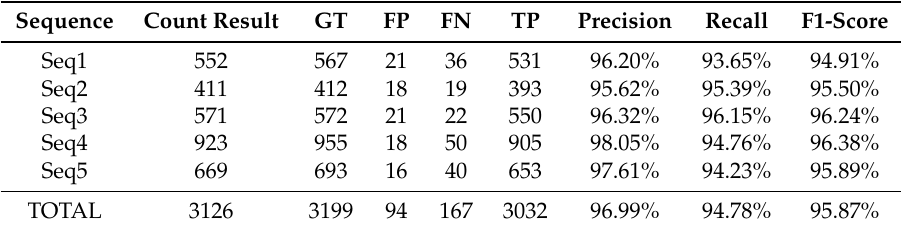
Table 2. The evaluation results of the algorithm in test videos.